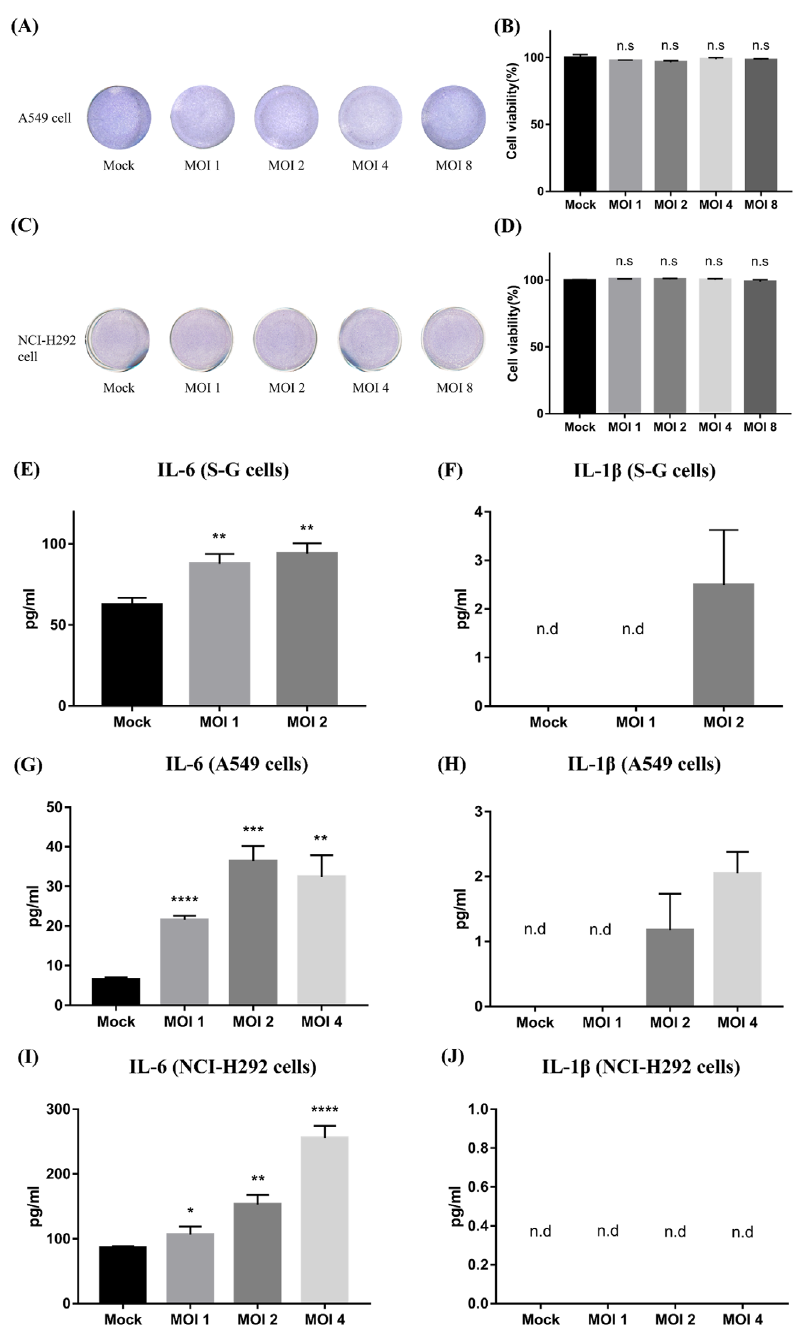
Figure 3. Cytopathic effect and cytokine production of S-G, A549, and NCI-H292 cells after stimulation by Trichomonas tenax . A549 (A, B) and NCI-H292 cells (C, D) were co-incubated with T. tenax for 24 h, the attached cells were then stained with Giemsa buffer and the percentage of stained cells was calculated by ImageJ. S-G (E, F), A549 (G, H) and NCI-H292 (I, J) cells were treated with T. tenax at different MOIs for 24 h, and the concentration of IL-6 and IL-1 b were detected by ELISA (n.d: not detection, n.s: not signi fi cant, ** p (cid:3) 0.01, *** p (cid:3) 0.001, **** p (cid:3) 0.0001, MOI: multiplicity of